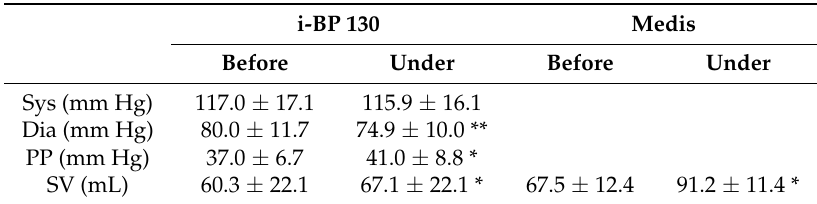
Table 1. The results of all the